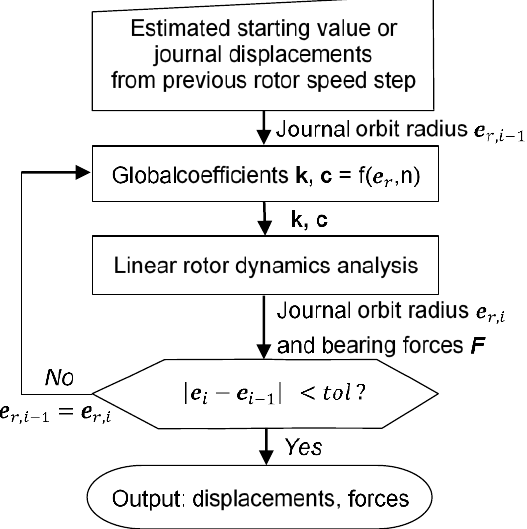
Figure 5. Flow chart of the quasilinear analysis (QLIN).